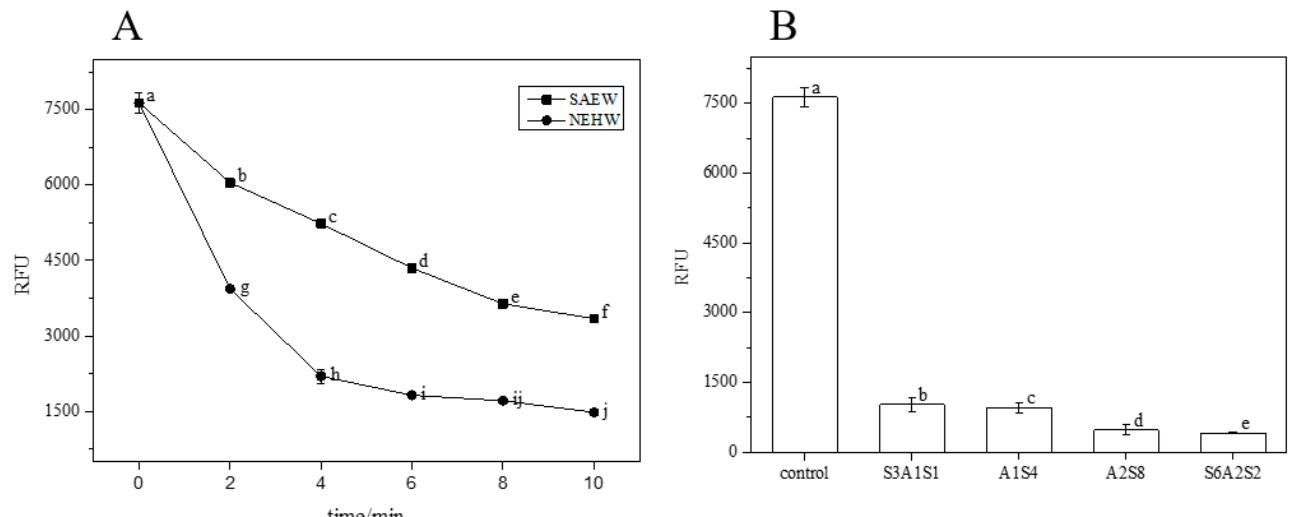
Figure 13. The CLSM images analysed by ISA-2 software to determine the biovolume (BV), mean thickness (MT), porosity (P) and biofilm roughness (BFR) of the biofilm. Data were expressed by mean measurements ± standard deviation (SD) and all treatments and determinations were performed in triplicate. The different letters indicate significant differences ( p < 0.05).